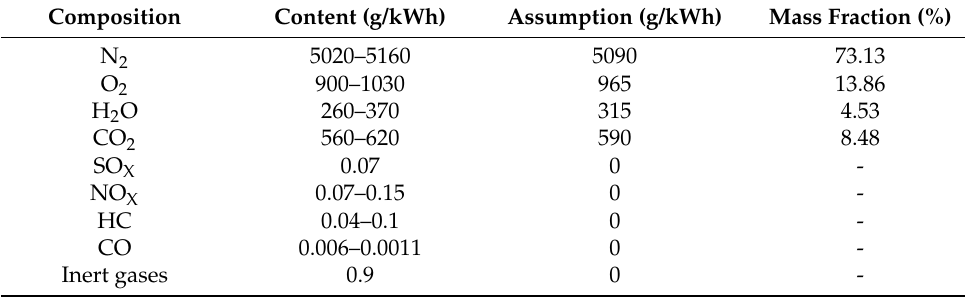
Table A2. Composition of the dual fuel engine exhaust